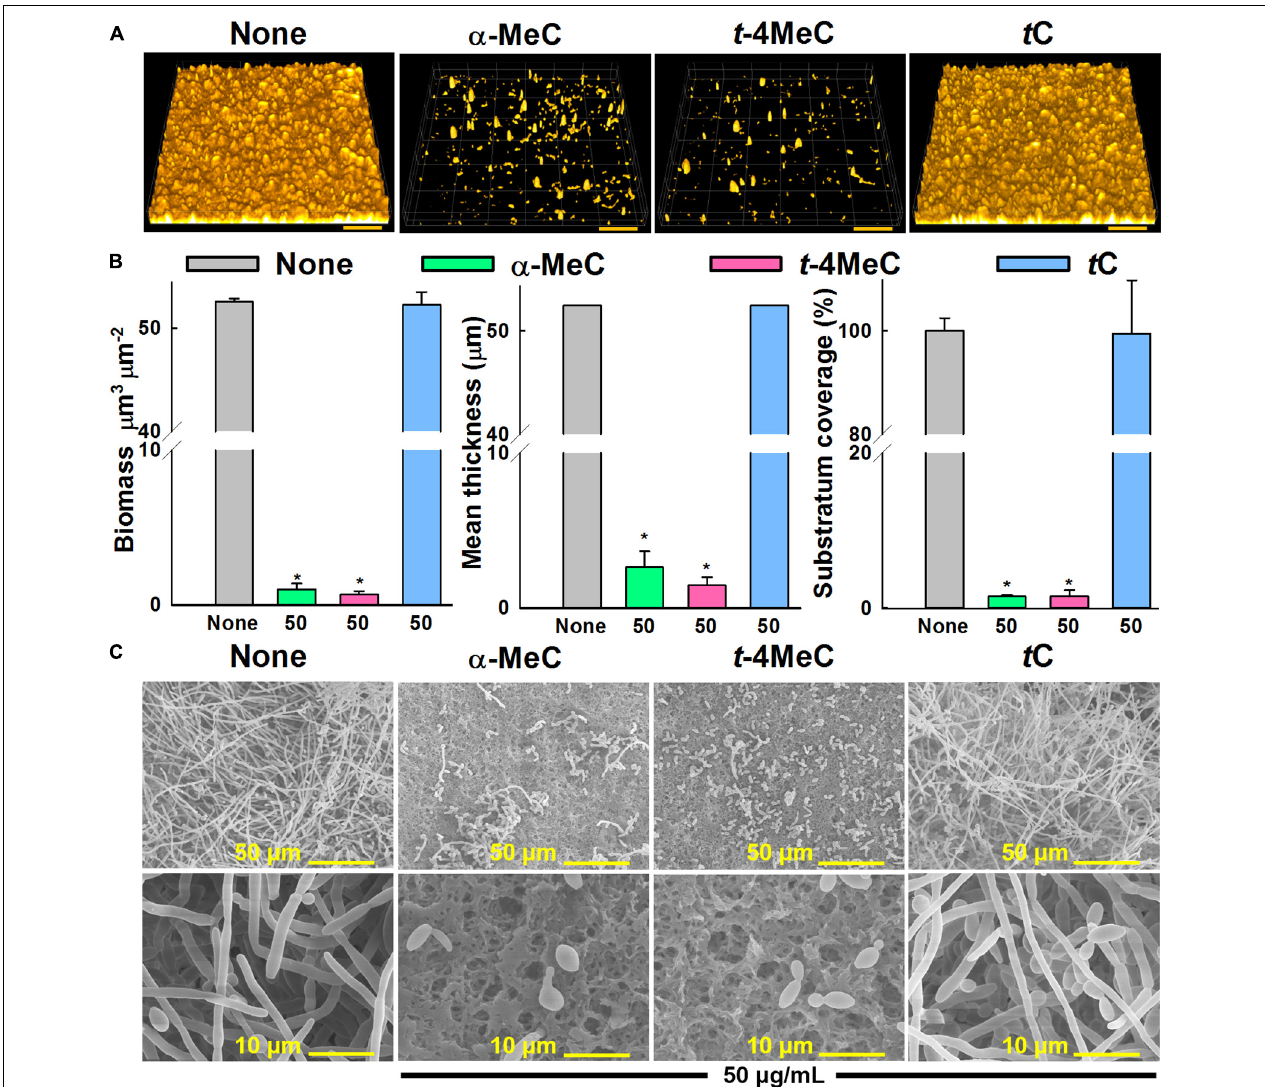
FIGURE 3 | Effect of α -methyl ( α -MeC) and trans- 4-methyl ( t -4MeC) cinnamaldehydes on C. albicans DAY185 biofilms. C. albicans DAY185 biofilm formation in the presence of α -methyl cinnamaldehyde ( α -MeC), trans- 4-methyl cinnamaldehyde ( t -4MeC), or trans- cinnamaldehyde ( t C) at 50 µ g/mL was examined by confocal laser microscopy (A) , C. albicans DAY185 biofilm formations were quantified by COMSTAT analysis (B) , C. albicans DAY185 biofilm formations on nylon membranes grown in the presence of α -methyl cinnamaldehyde ( α -MeC), trans- 4-methyl cinnamaldehyde ( t -4MeC), or trans- cinnamaldehyde ( t C) at 50 µ g/mL were observed by SEM (C) . The scale bars in panel (A) represent 100 µ m and in panel (B) represent 50 and 10 µ m. Error bars indicate standard deviations. * P < 0.05 vs. non-treated controls (None). None indicates biofilm formation without treatment after 24 h